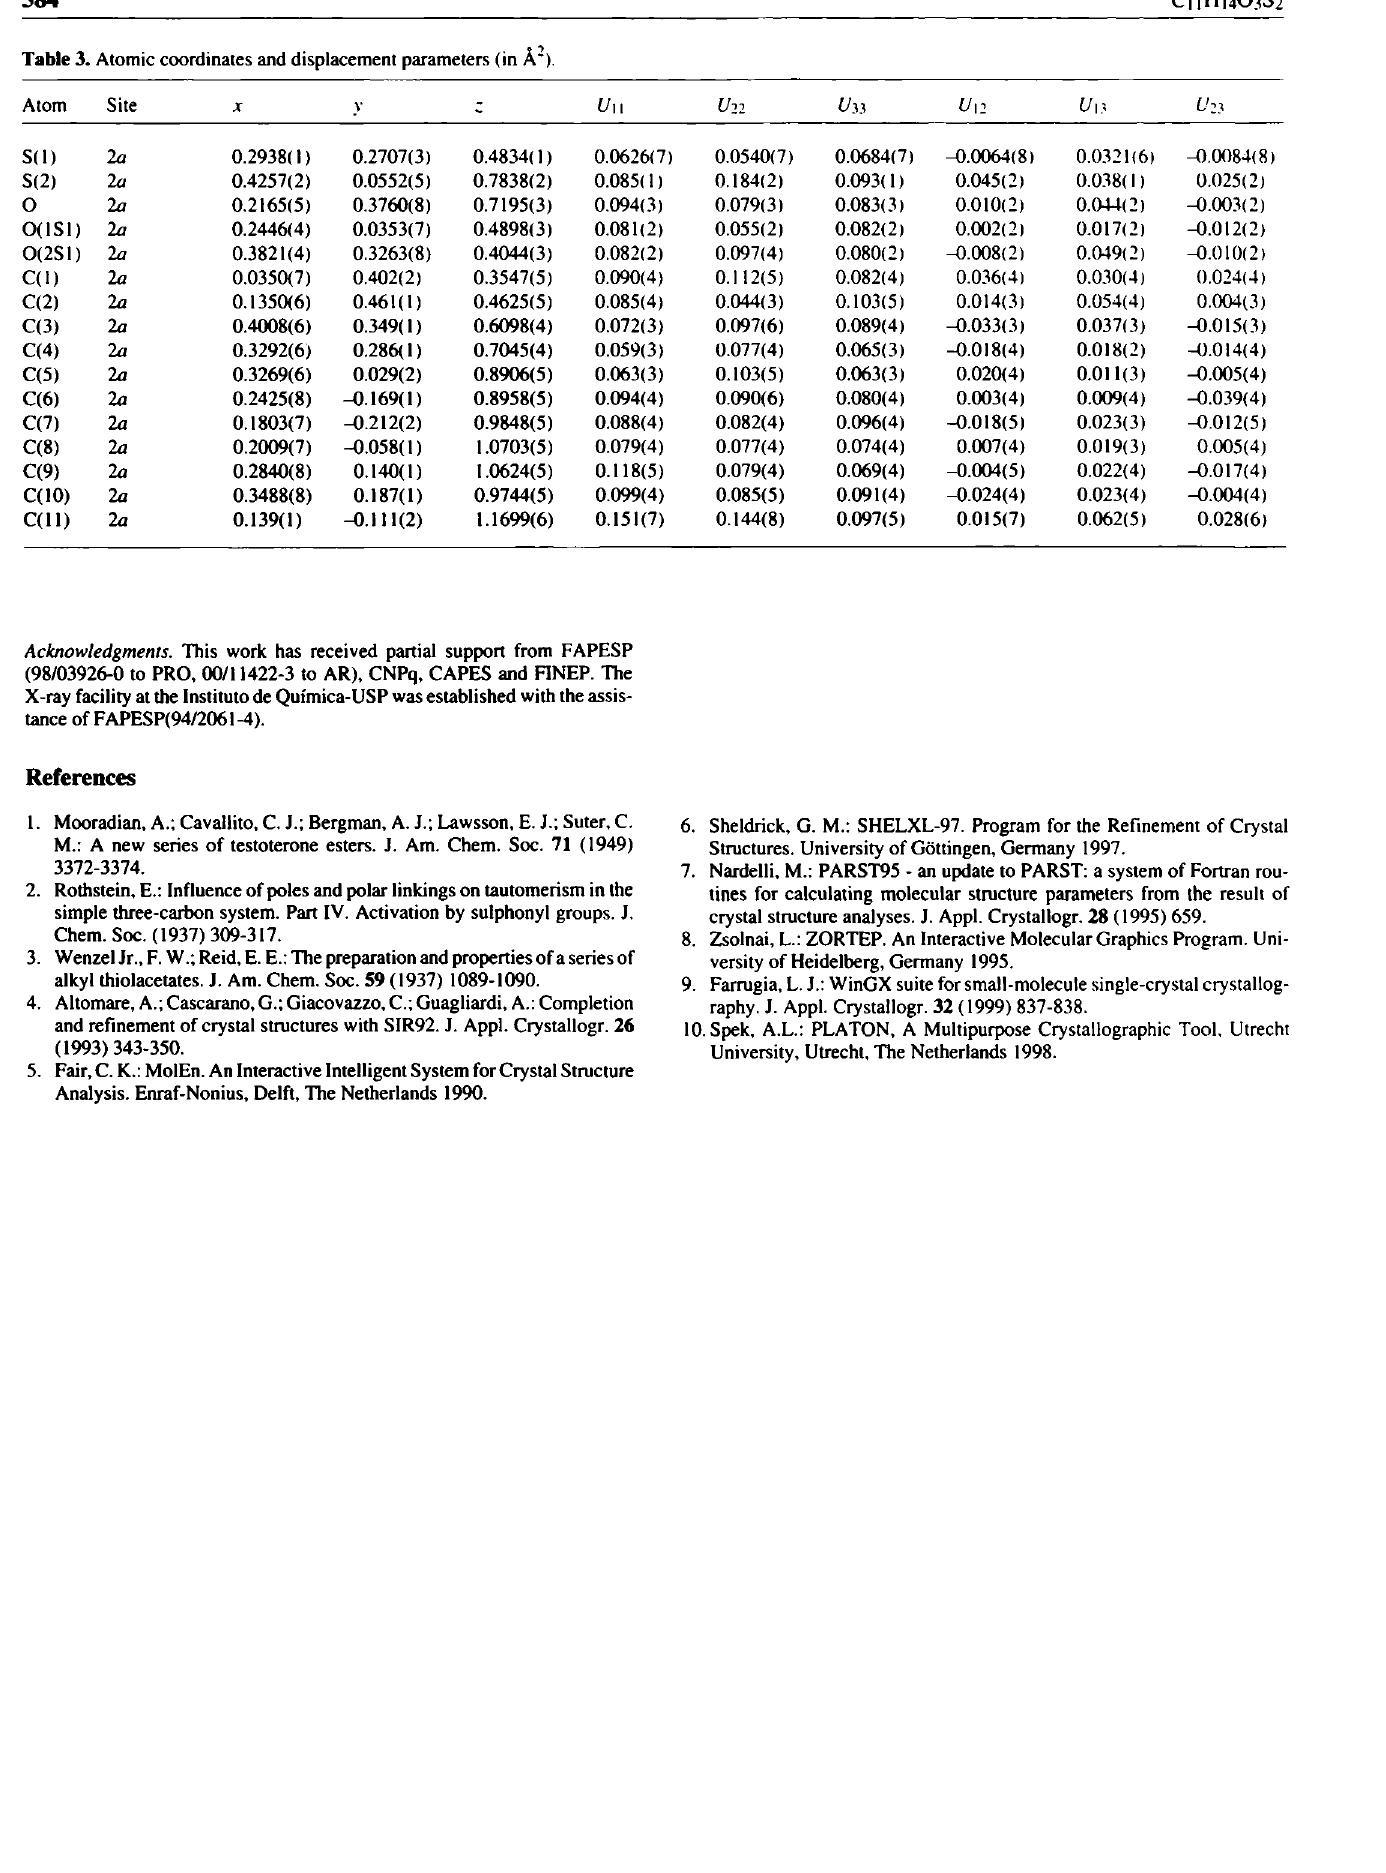
Table 3. Atomic coordinates and displacement parameters (in A") Atom